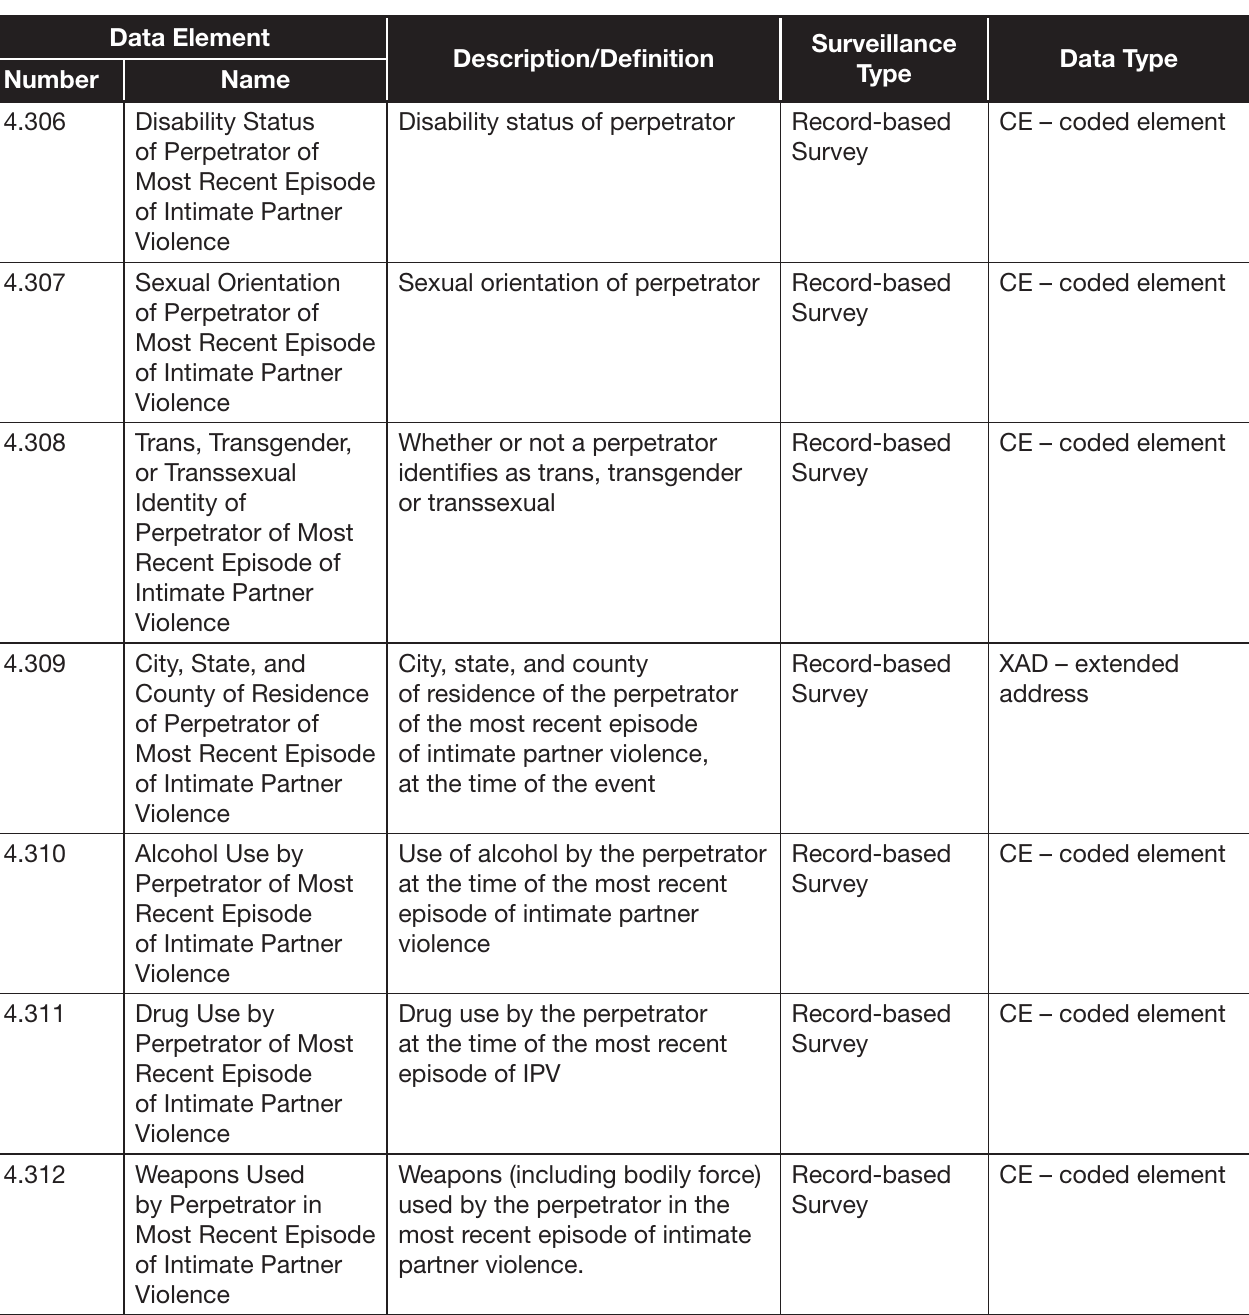
INTIMATE PARTNER VIOLENCE: UNIFORM DEFINITIONS AND RECOMMENDED DATA